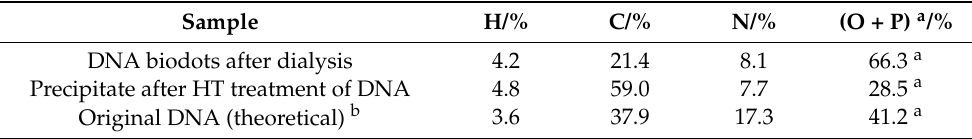
Table 1. Elemental analysis of DNA biodots and the insoluble